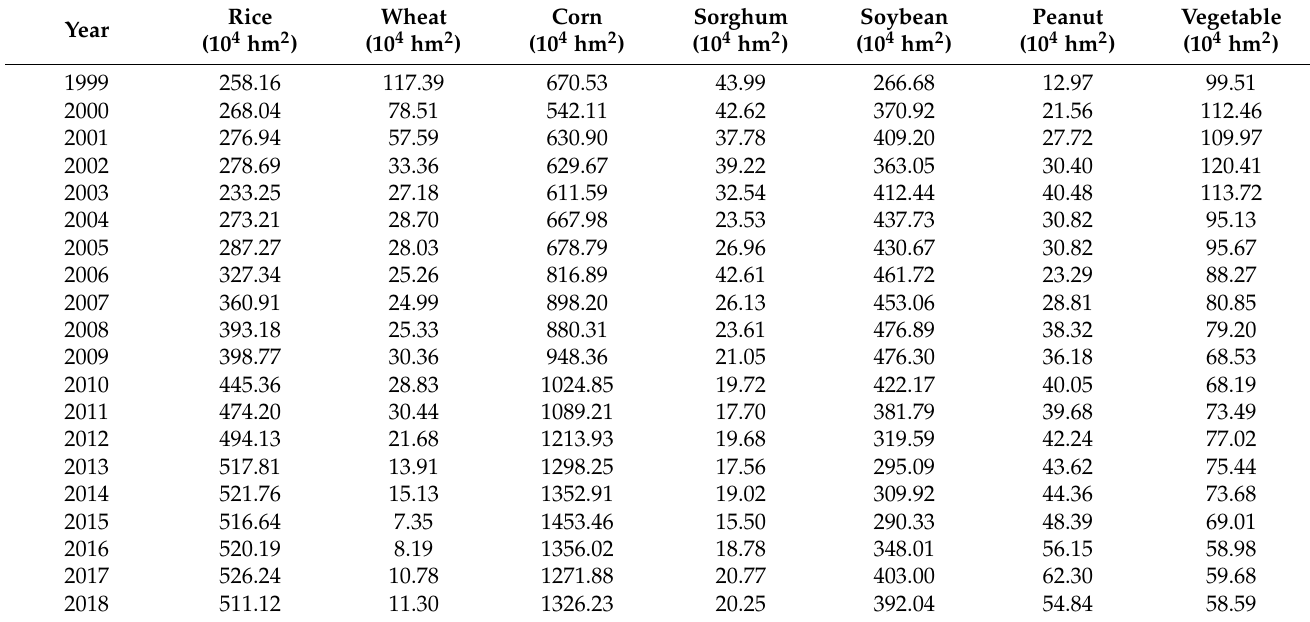
Table 1. Planting area of different crops in Northeast China.